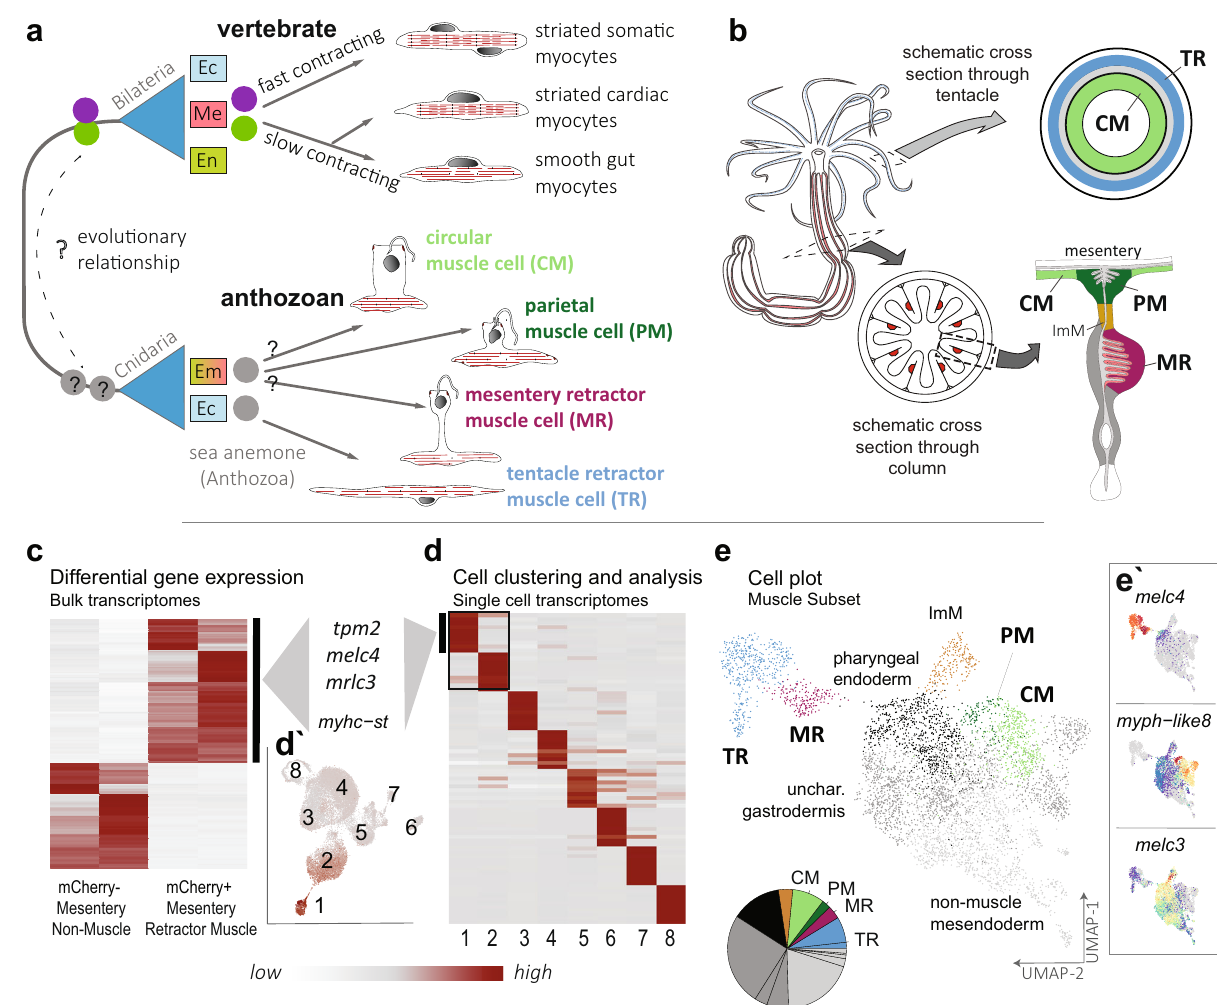
Fig.1|Distinctmusclecelltypesintheseaanemone Nematostellavectensis are identi fi ed from single-cell sequencing data. a Muscle cell relationships in ver- tebrates (Bilateria) and the sea anemone (Cnidaria). Two ancestral cell types cor- responding to a fast (purple circles) and slow (green circles) contracting phenotype derive from the mesoderm in vertebrates. Musclescan arise from both cell layers in the diploblastic sea anemone, but their contractile properties are undescribed (gray). Both the intra- and interspecies evolutionary relationships of these muscle types are unclear. Ec: ectoderm, Me: mesoderm, En: endoderm, Em: endomesoderm b Schematic view of Nematostella muscle systems: tentacle and mesenteryanatomyareillustratedschematicallyincrosssectionwiththepositions of the muscles indicated; blue: tentacle retractor (TR);light green: circularmuscle (CM); dark green: parietal muscle (PM); red: mesentery retractor (MR); ocher: the intermuscularmembrane(ImM) c Heatmapofdifferentiallyexpressedgenesofthe mesentery-derived bulk transcriptomes. Average gene expression from differen- tially expressed genes with less than a twofold change of expression between